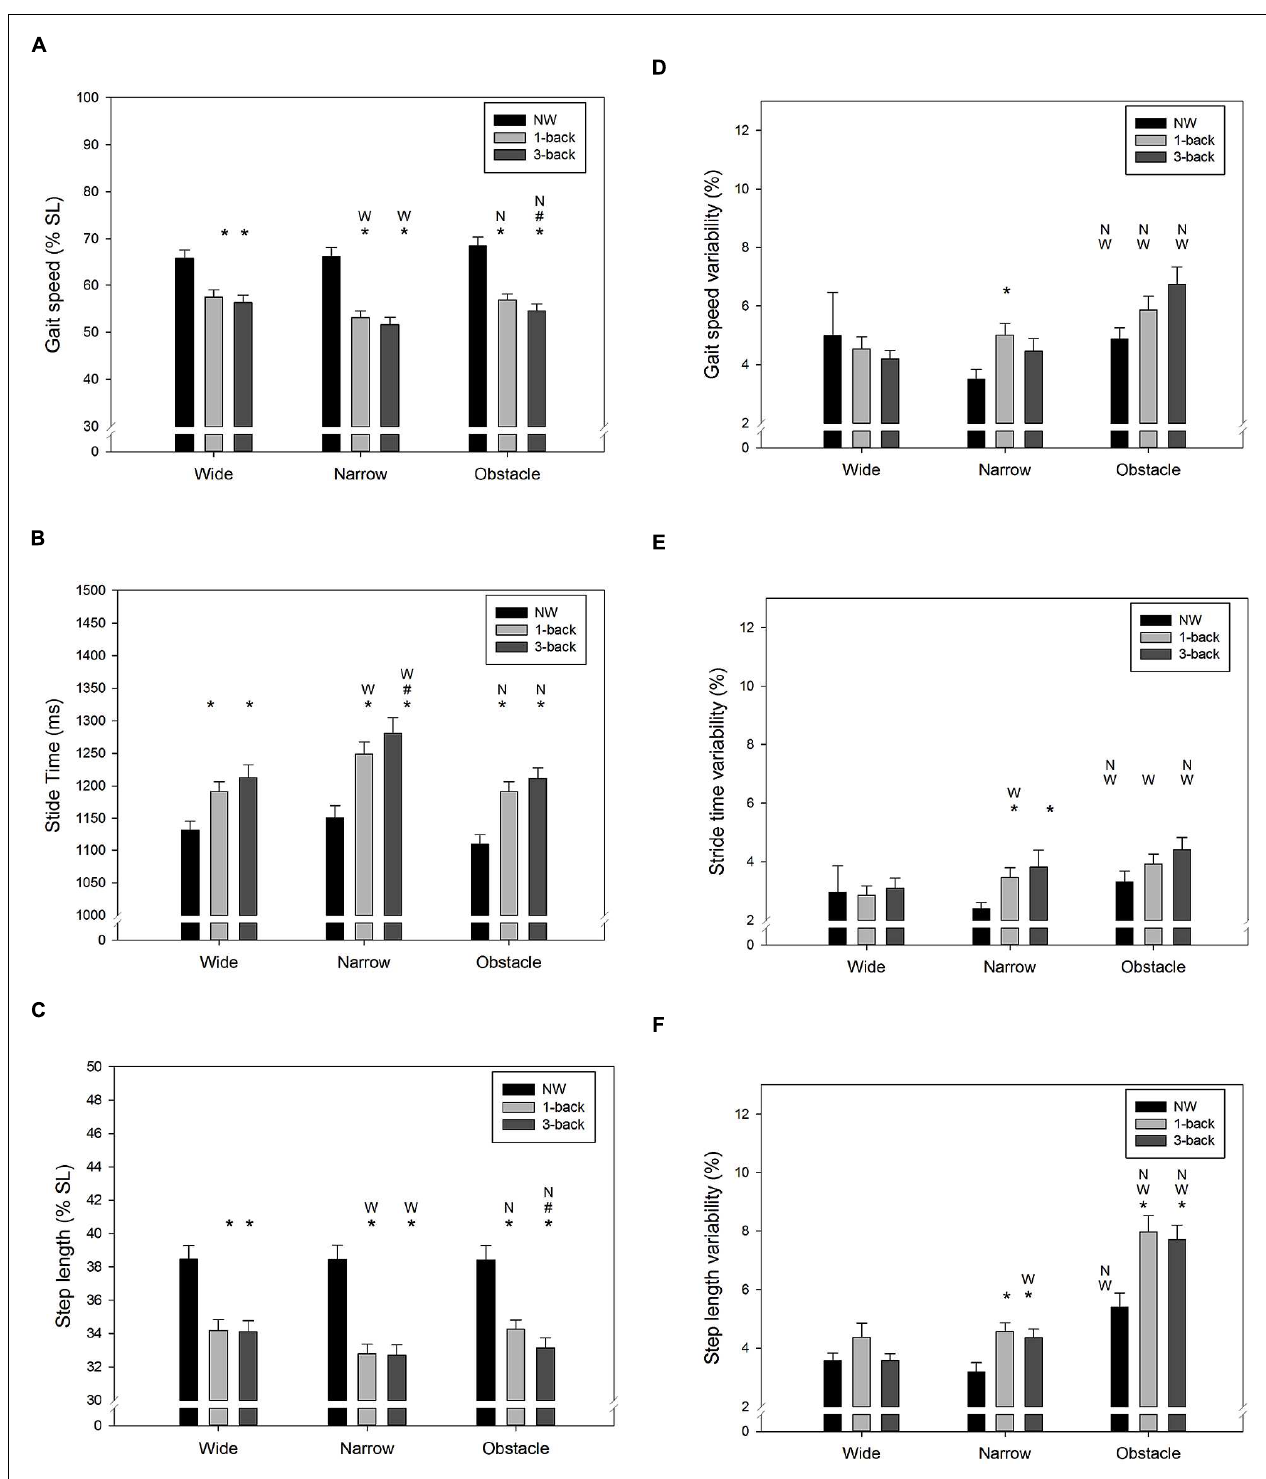
FIGURE 3 | Summary results of spatiotemporal gait parameters for (A) average gait speed, (B) average stride time, (C) average step length, (D) variability of gait speed, (E) variability of stride time, and (F) variability of step length in all combinations of cognitive task complexity and walking road condition. Error bars represent ± 1 SE. Under the same walking road condition, a significant difference ( p < 0.05) between the target cognitive task complexity and l-back/3-back task is denoted by the symbol asterisk ( ∗ )/pound (#), respectively. Under the same cognitive task complexity, a significant difference ( p < 0.05) between the target road condition and the wide/narrow road condition is denoted by the symbol W/N, respectively.